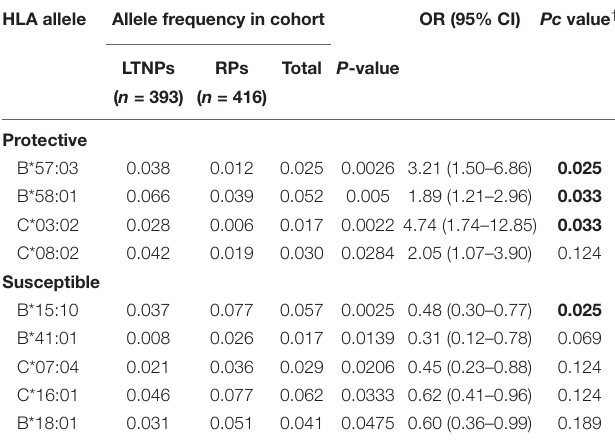
TABLE 3 | HLA alleles associated with LTNP in Uganda and Botswana.